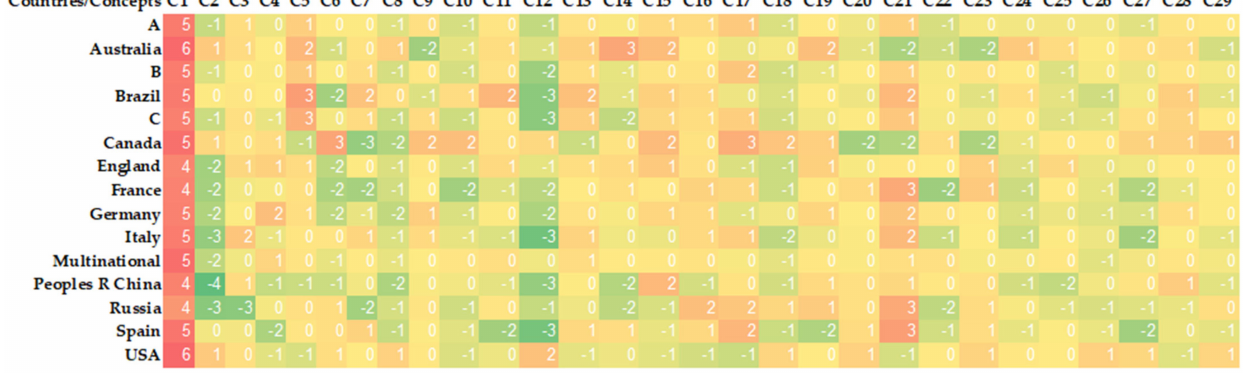
Figure 13. Heatmap of created concepts mean importance weights ( × 10 − 3 ) by